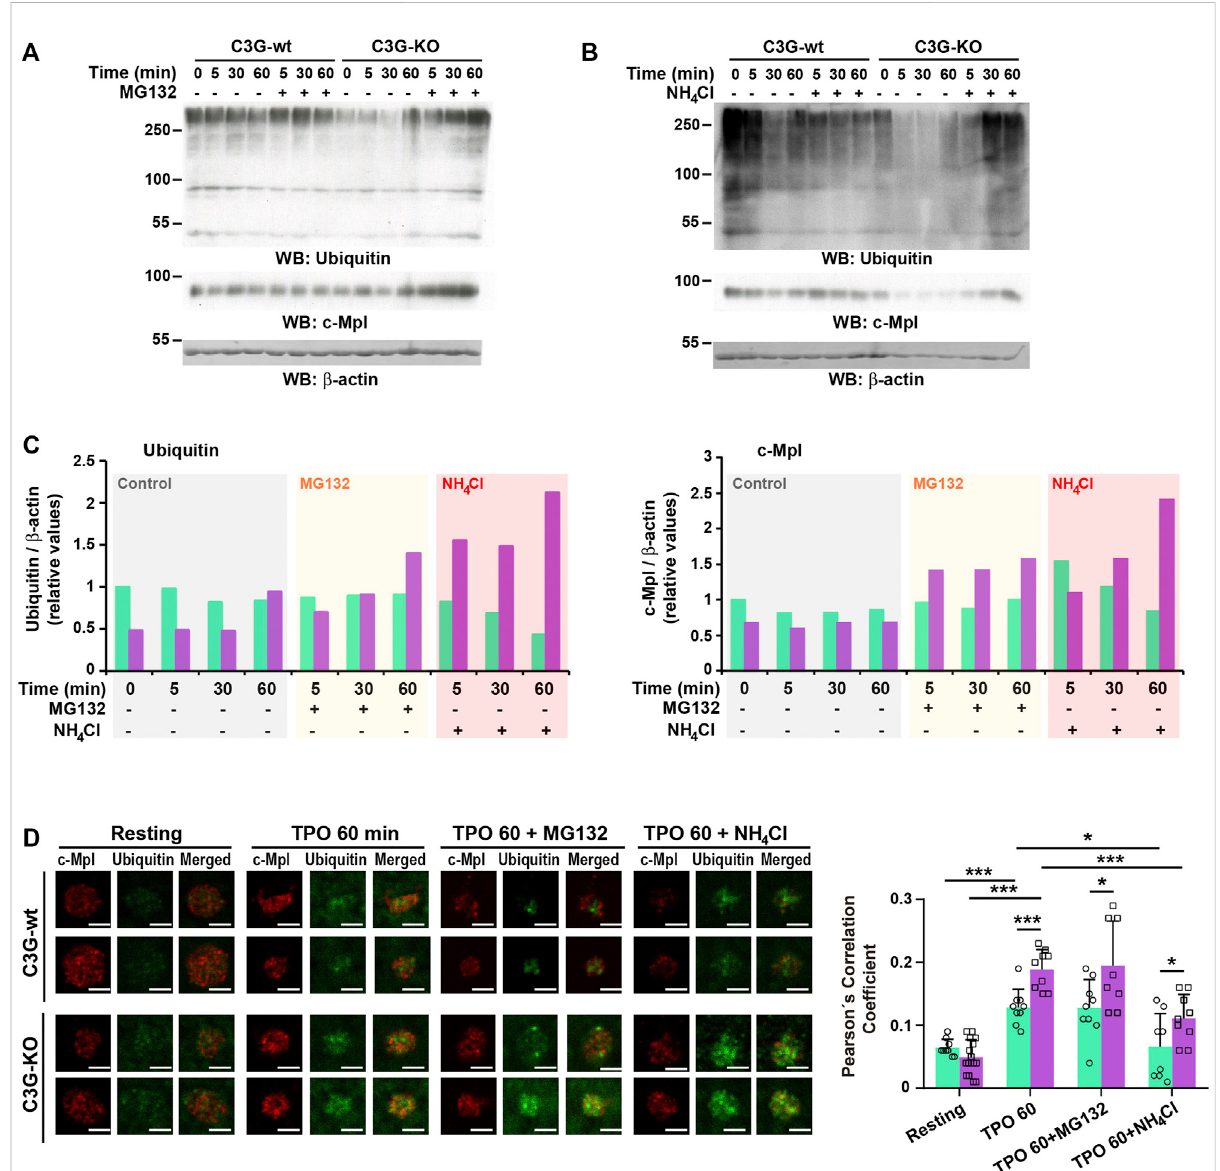
FIGURE 7 C3Gplaysaroleinproteasome-andlysosome-mediateddegradationofc-Mpl.PlateletsfromC3G-KOandC3G-wtmicewerepre-treated1 h with 30 μ M MG132 (A) or 20 mM NH 4 Cl (B) prior incubation with 100 ng/ml TPO for the indicated times. The levels of ubiquitinated proteins and c-Mpl were measured by western blot using β -actin as loading control. (C) Histograms represent the quanti fi cation of ubiquitinated proteins (left panel) and c-Mpl levels (right panel) relative to β -actin and normalized against the t0 value of C3G-wt. (D) C3G-KO and C3G-wt platelets were treated with 100 ng/ml TPO for 60 min, after 1 h pre-treatment with 30 μ M MG132 or 2 mM NH 4 Cl and labeled with anti-c-Mpl + Fluor TM -568 (red) or anti-Ubiquitin + Alexa Fluor TM -647 (green). Representative immuno fl uorescence images of platelets of each genotype under each treatment condition,takenatthesameexposuretime.Bar:2.5 μ m.ThegraphshowsthePearson ’ sCorrelationCoef fi cients(mean±SD)ofc-MplandUbiquitin under the indicated experimental conditions. * p < 0.05, *** p <